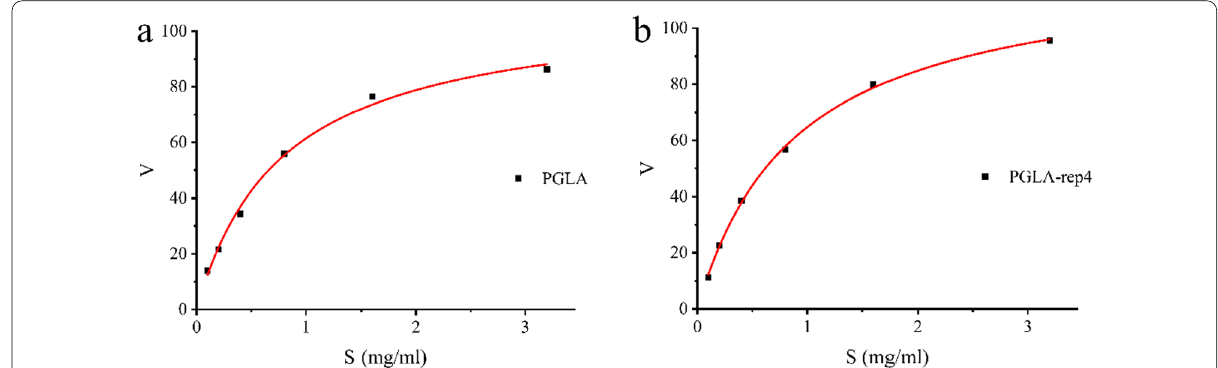
Fig. 5 Nonlinear regression curves for the enzymatic reaction of pectin lyase. a PGLA reaction, b PGLA‑rep4 reaction